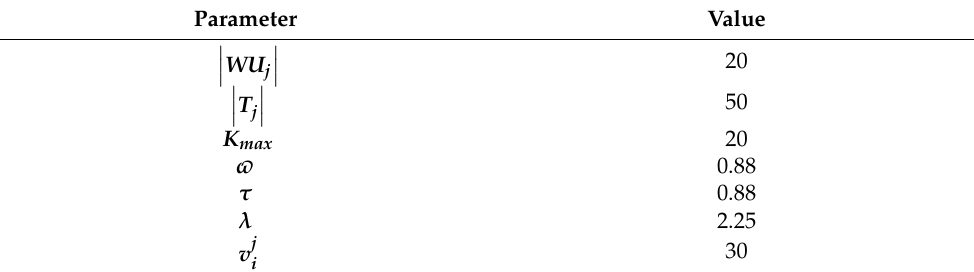
Table 2. Experimental parameter settings.